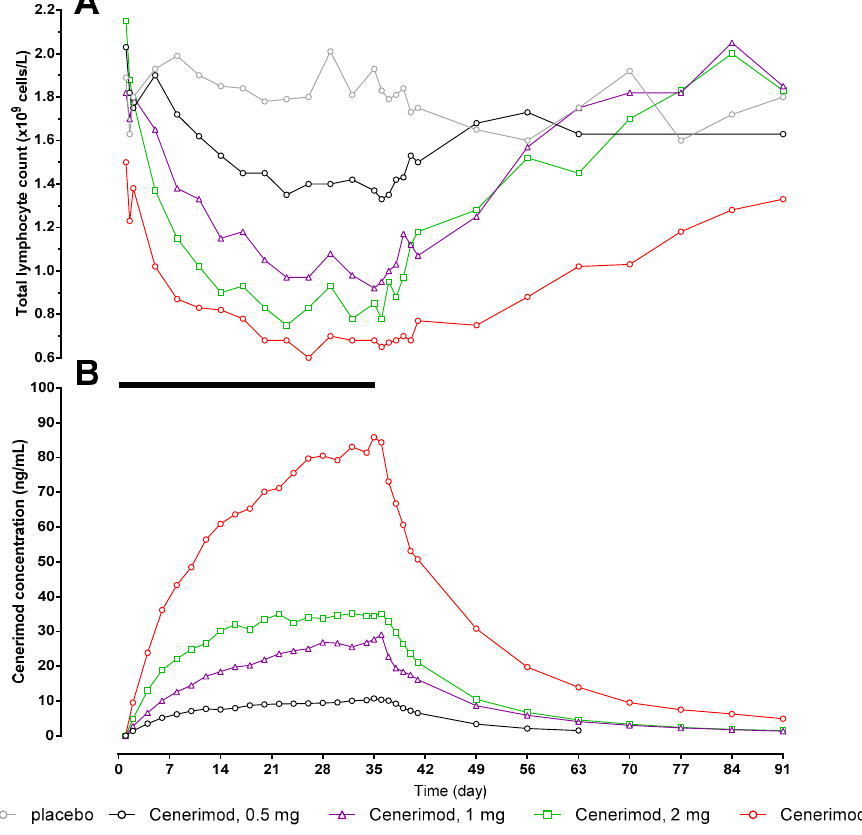
Figure 3. Arithmetic mean total lymphocyte count (Panel ( A )) and cenerimod concentration (Panel ( B )) versus time profiles from 0 h to EOS after multiple-dose o.d. oral doses of cenerimod (Study 2) for 35 days ( N = 6 per dose group, N = 8 for placebo group). The black bar represents the treatment duration. EOS: end-of-study.